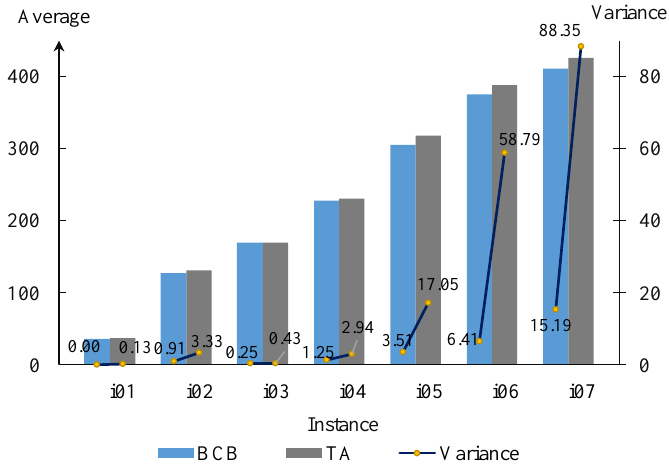
Figure 6. The results of BCB and time adjustment